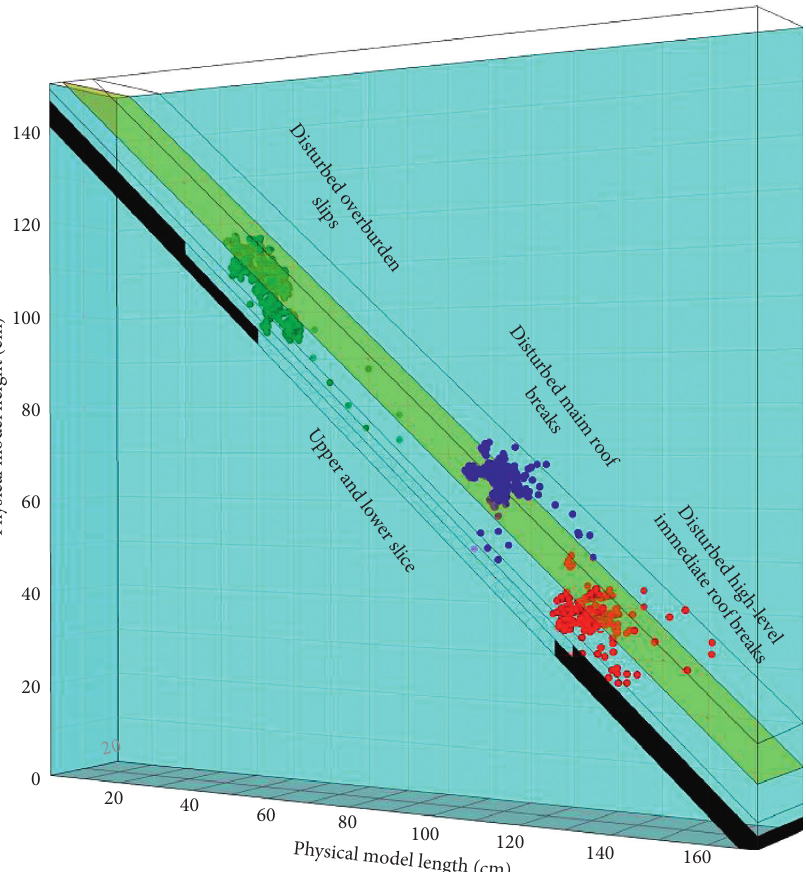
Figure 7: Disturbed overburden rupture AE spatial positioning